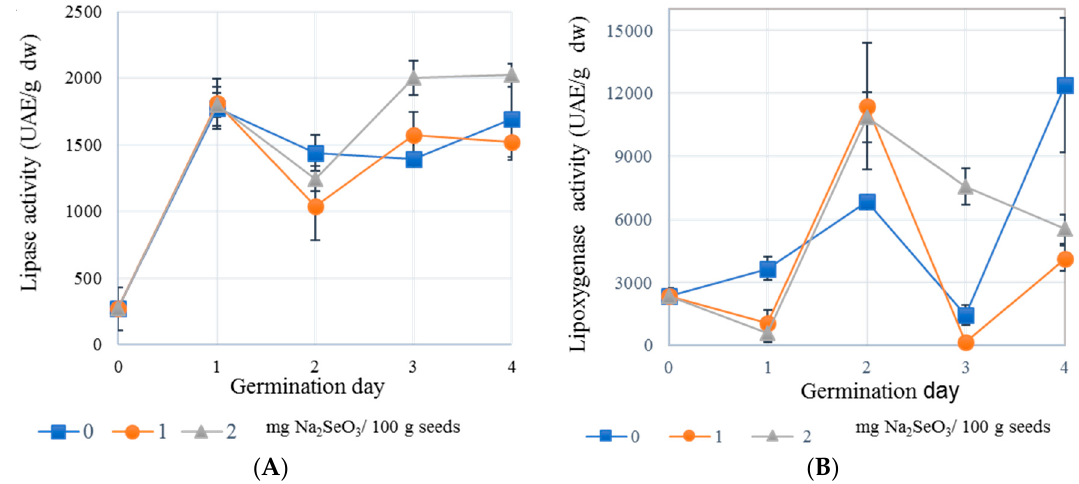
Figure 1. Effect of sodium selenite concentrations on lipase ( A ) and lipoxygenase ( B ) activities of chickpea sprouts germinated for four days. Values depicted are averages and bars represent standard deviations.